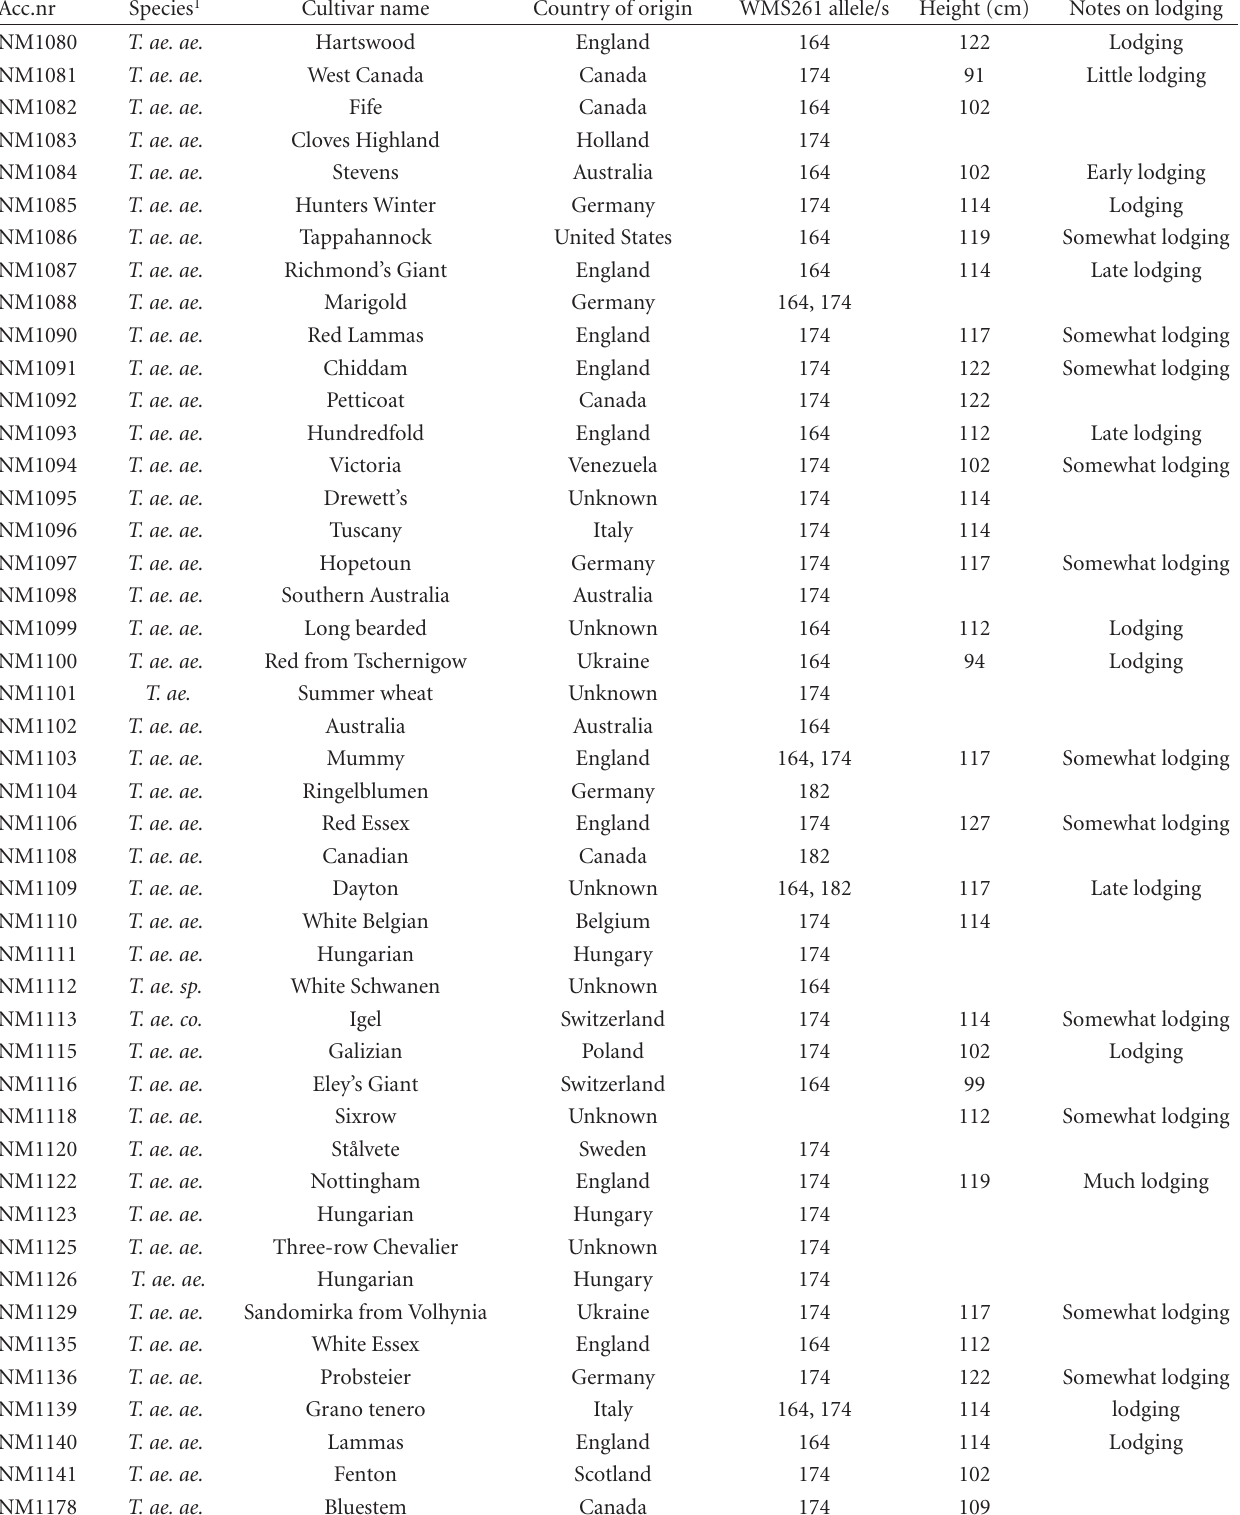
Table 2: Historical cultivars screened for WMS261 allelic diversity. Acc.nr refers to the seed collection inventory number in the Swedish Museum of Cultural History. Data on height and lodging are from Juhlin Dannfelt [21].